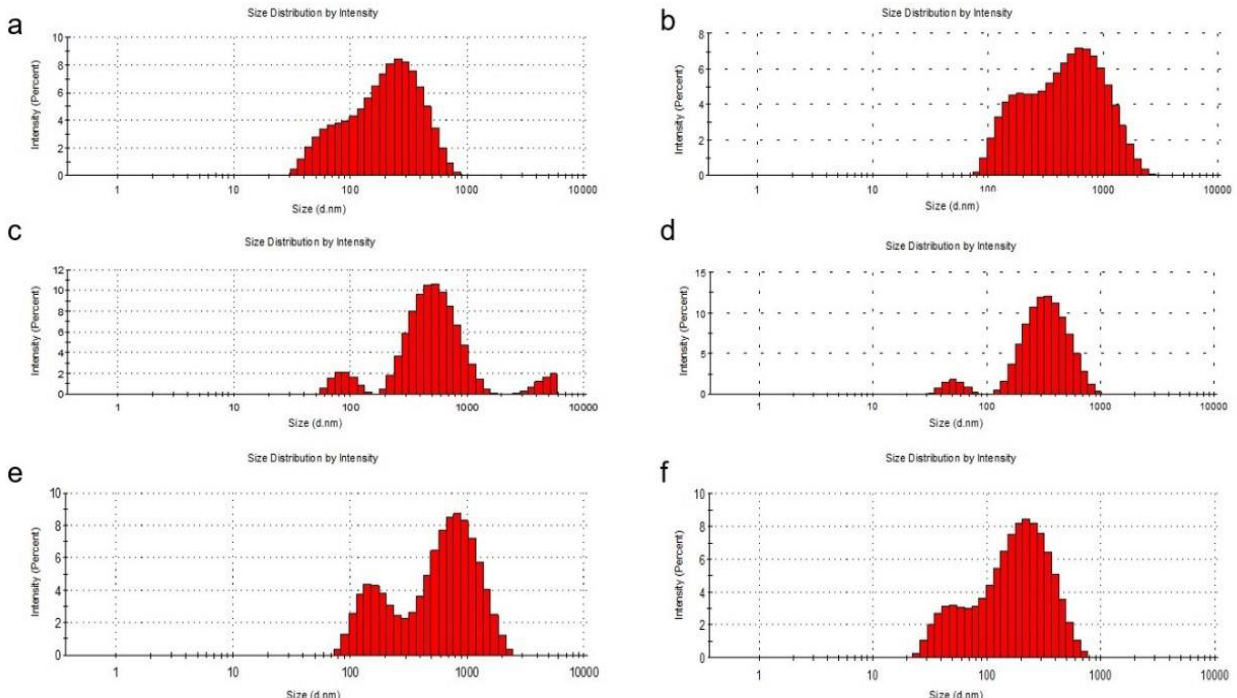
Figure 1. DLS analysis of the liposomal systems. Particle size distribution of the L1 ( a ), L2 ( b ), L3 ( c ), L4 ( d ), L5 ( e ) and L6 ( f ) formulations.